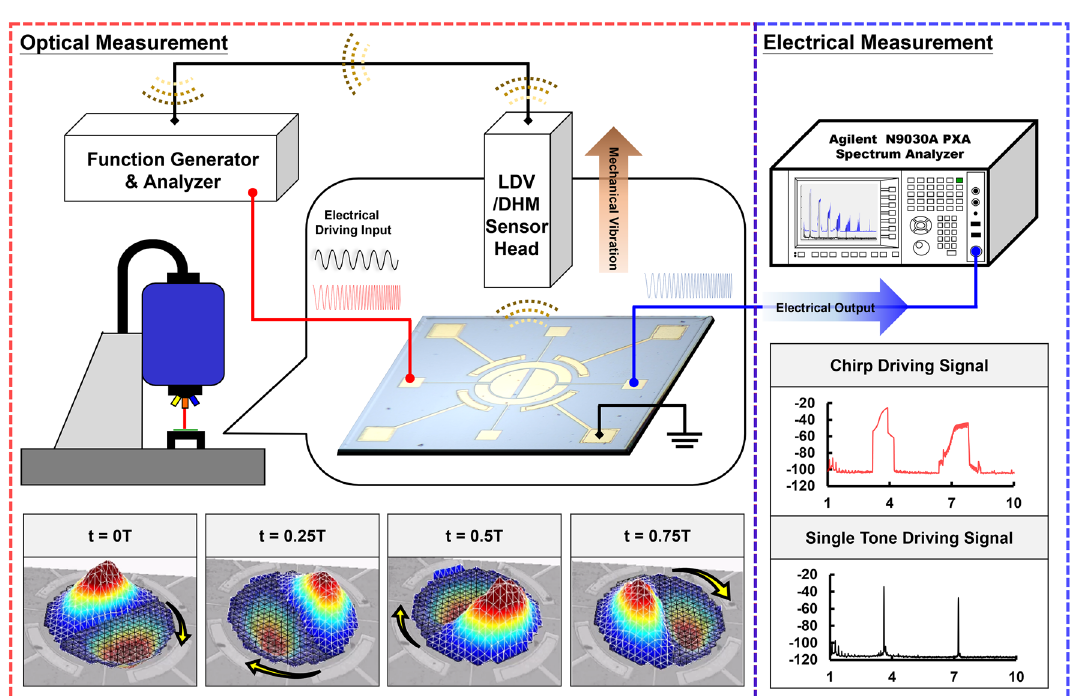
Figure 9. Measurement setup. The function generator provides an electrical driving input (chirp driving signal or single-tone driving signal) to actuate the resonator. The real-time mechanical vibration (Ex: the snapshots of mechanical rotation motion) can be recorded through the optical measurement performed by LDV or DHM. In addition, through the integrated inner electrodes, the electrical output can be measured by a spectrum analyzer in Max-hold mode